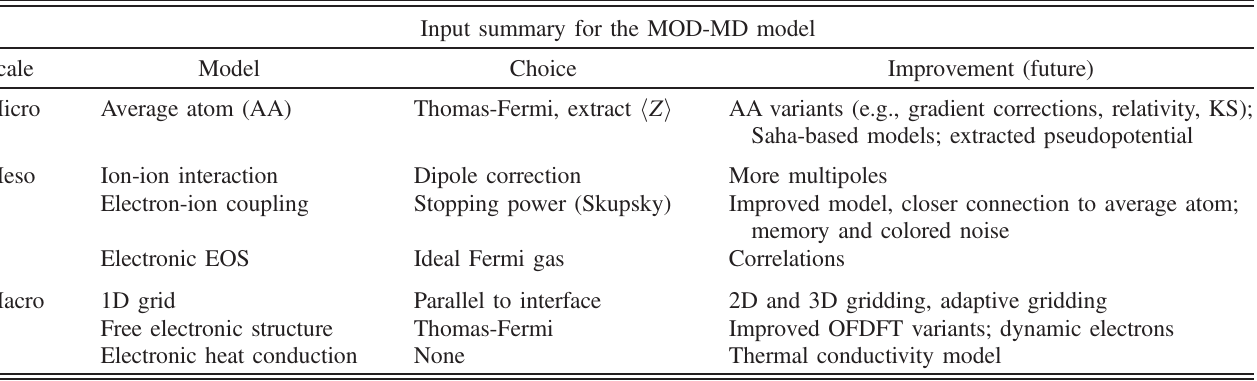
TABLE I. A summary of the various inputs to the MOD-MD model is given, along with improvements we feel are the next obvious step. Because of the multiscale nature of MOD-MD, most models can be improved independently; however, improvements are also possible by enforcing higher degrees of self-consistency among the